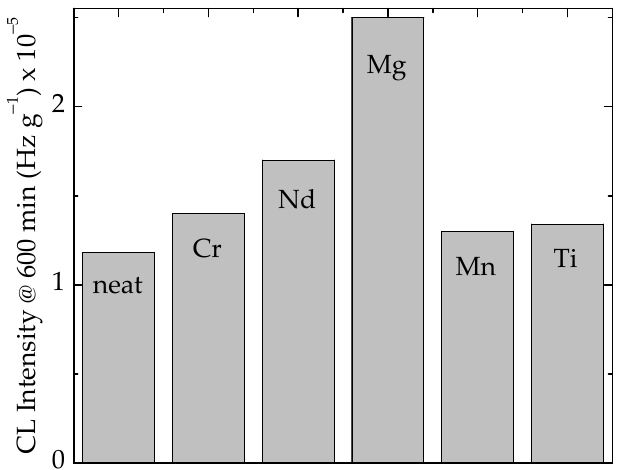
Figure 5. The isothermal CL spectra recorded on the pristine PCL-based samples containing PbZrO 3 doped with various metallic atoms after receiving a γ -dose of 100 kGy. Testing temperature: 140 °C.